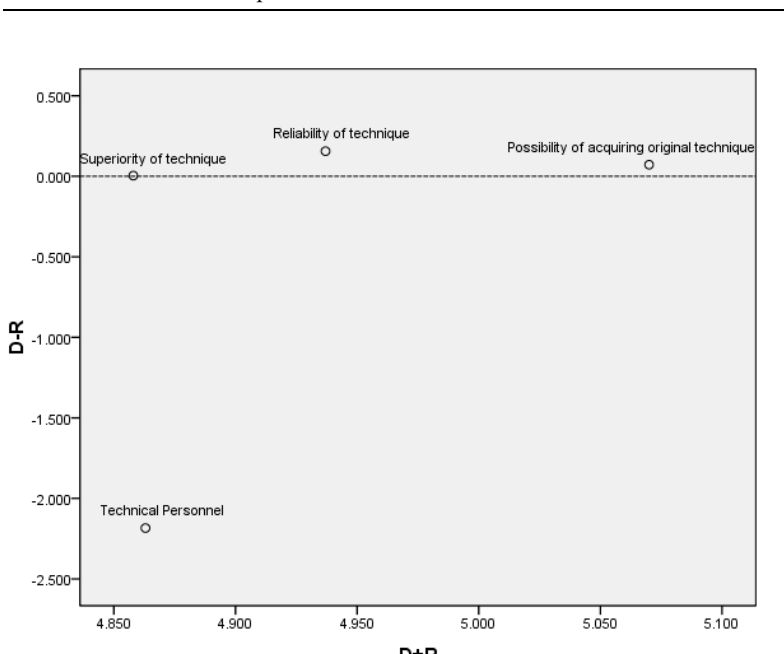
Table 7. The sum of (cid:101) R i value , (cid:101) C i value , (cid:101) R i + (cid:101) C i value and (cid:101) R i − (cid:101) C i value impacts of the second-level criteria of the government policy.